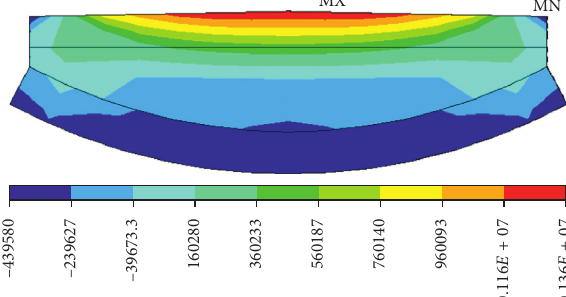
Figure 7: First principal stress of tunnel substructure (Pa).